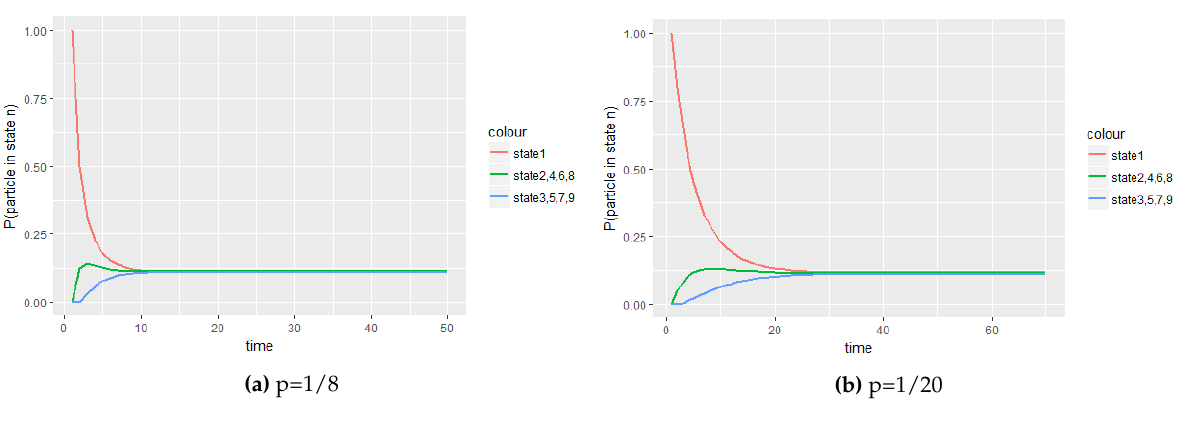
= ( 1,0,0,0,0,0,0,0,0 ) . From these 1